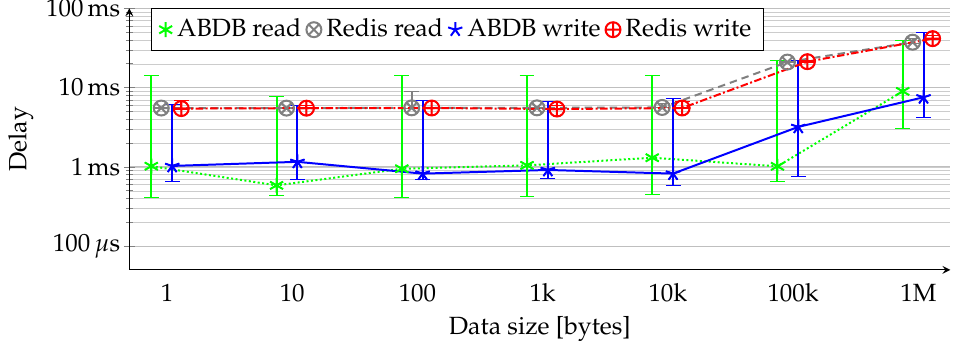
Figure 8. Data access performance of functions deployed to an edge node where only an ABDB child is available. Redis can be accessed on a separate node with a configured delay offset of 5ms. Maximum, average and minimum values are shown.